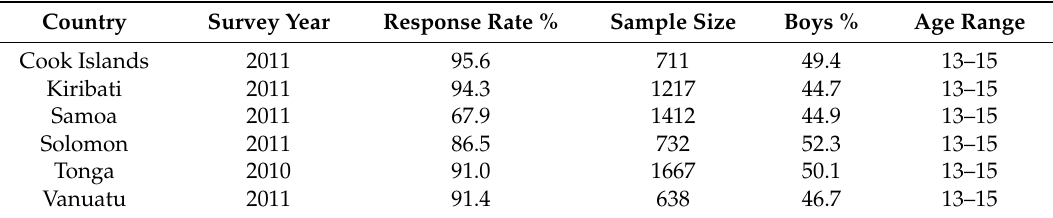
Characteristics of the Global School-Based Student Health Surveys in 6 low- and